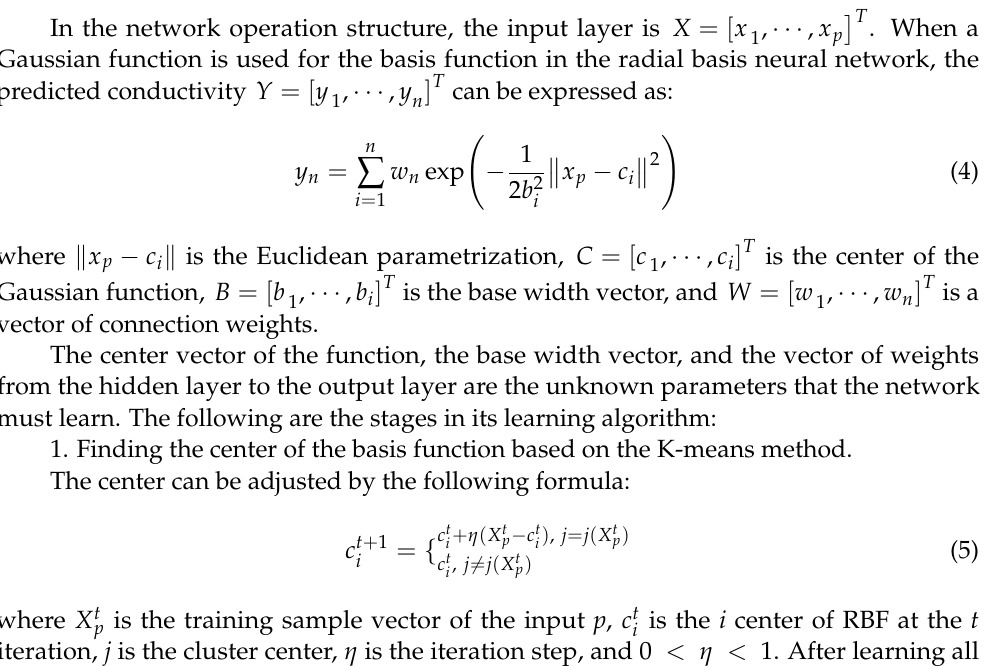
Figure 2. The classical RBFNN algorithm flow. The K-means algorithm is used to adjust the network center, the KNN algorithm to determine the network base width, and the LSM algorithm to calculate the connection weights to finally obtain the predicted conductivity of the EIT reconstructed image.